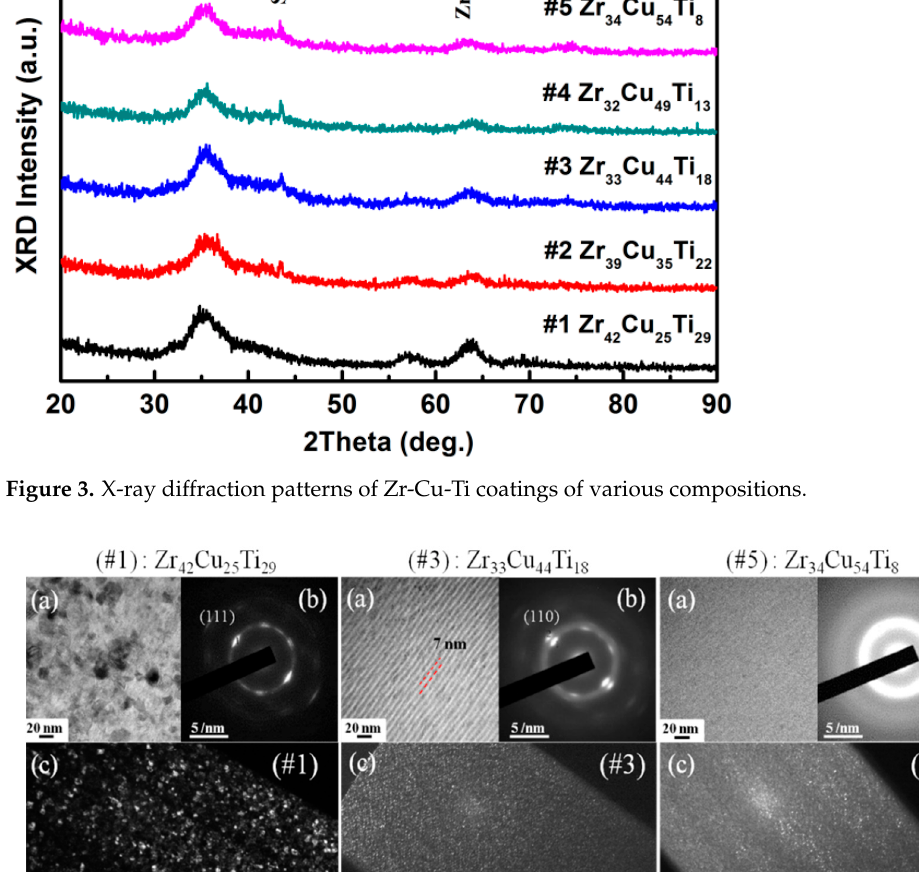
Figure 3. X-ray diffraction patterns of Zr-Cu-Ti coatings of various compositions.